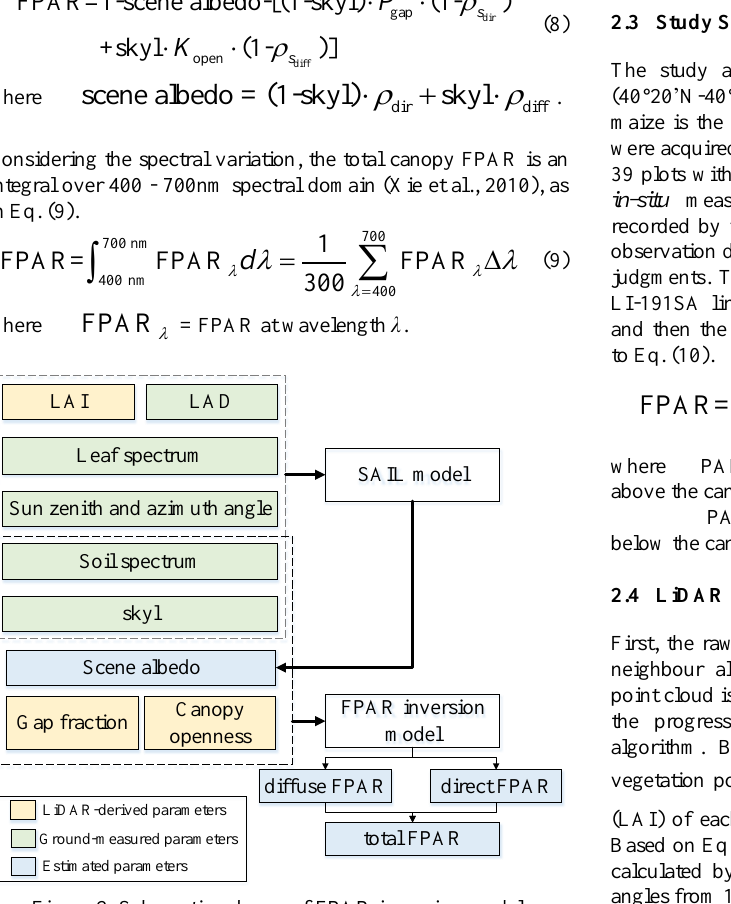
Figure 2. Schematic scheme of FPAR inversion model From Eq. (8), it is seen that FPAR is a parameter related to vegetation structure, vegetation spectrum, soil spectrum and skylight environment. In this study, we used the SAIL model (Verhoef, 1984) to simulate the scene albedo in 400-700